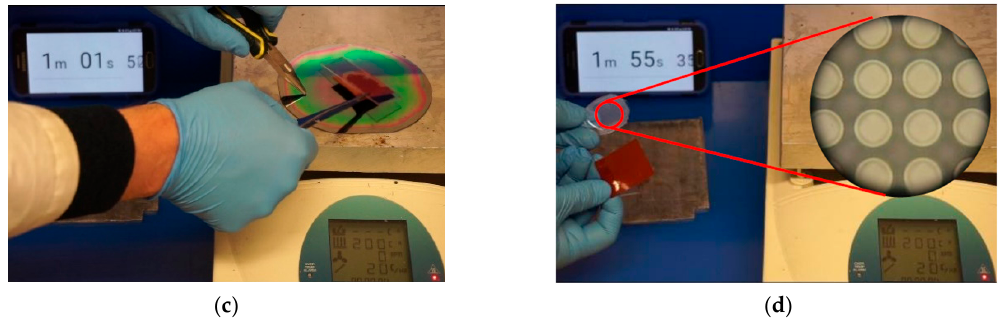
Figure 6. Flash curing of PDMS samples via fluorosilicone mold: ( a ) Sylgard-184 is rubbed on the fluorosilicone mold; ( b ) Sylagrd-184 is heated at 200 °C; ( c ) the sample is removed after 1 min; ( d ) the sample is demolded and inspected.